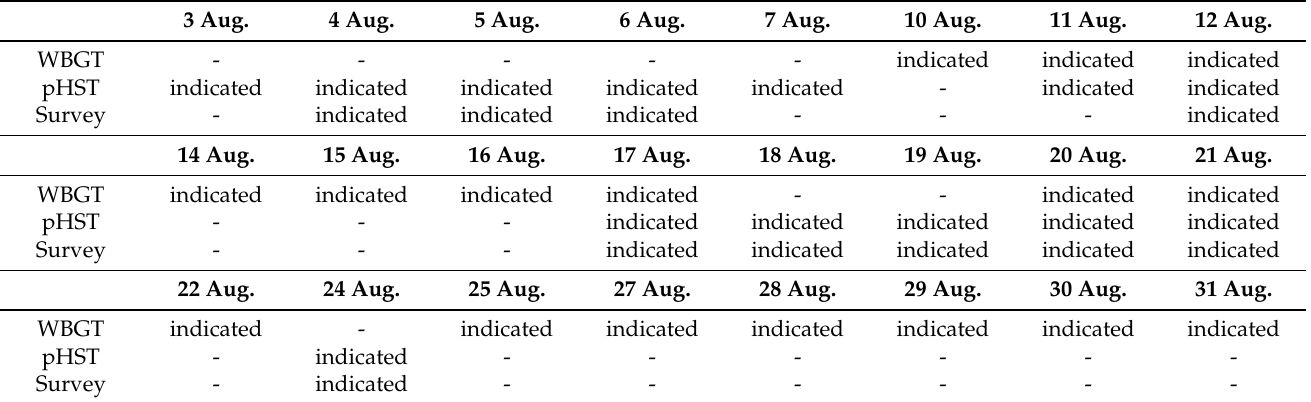
Table 2. Heat strain indication results based on WBGT and